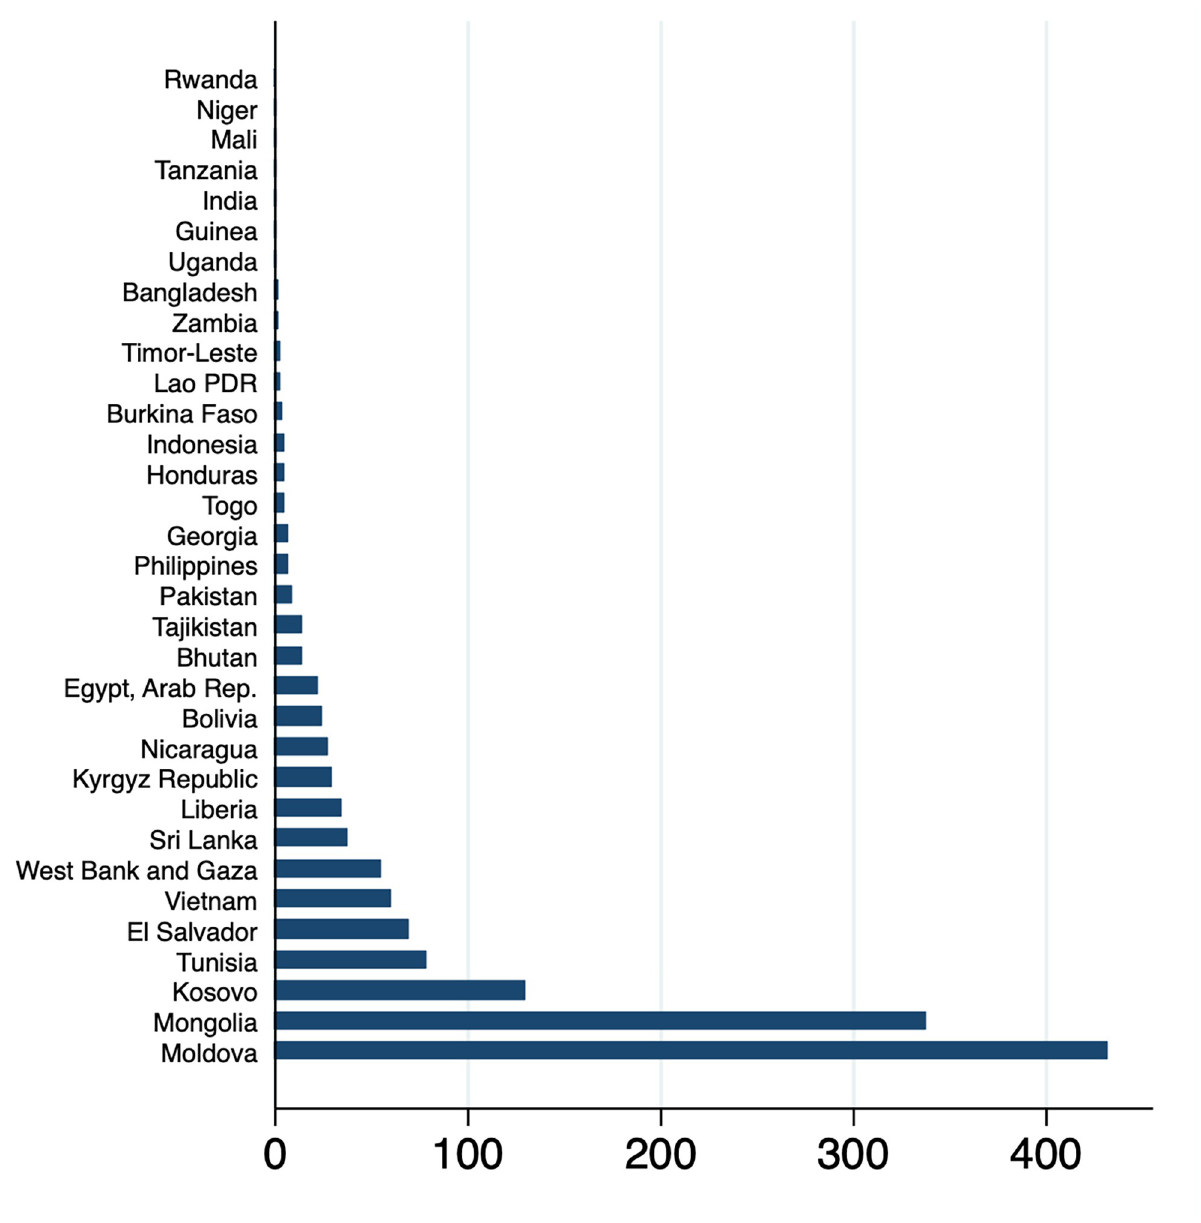
Fig 2. Estimated country-specific costs per poverty case averted using social protection program data. Notes: Source: The World Bank Atlas of Social Protection Indicators of Resilience and Equity (ASPIRE). Sample includes low-income and lower-middle-income countries. Costs are in 1,000